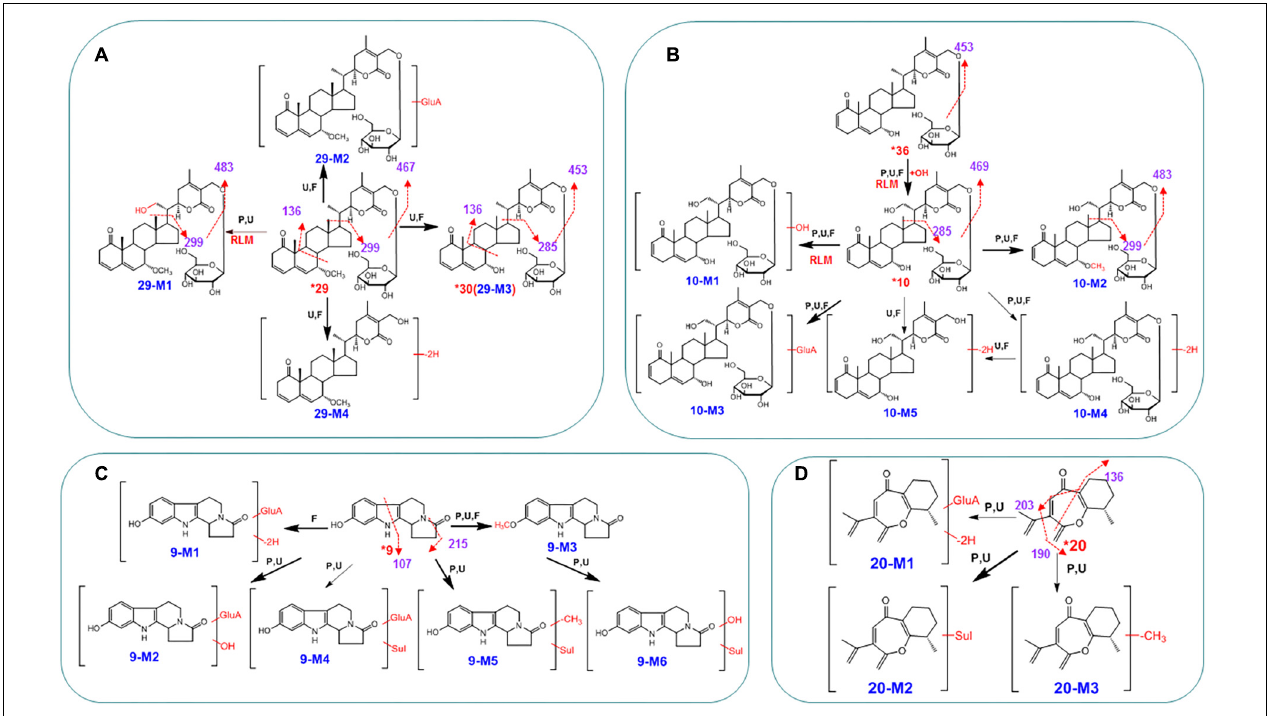
FIGURE 4 | The proposed metabolic pathways for compounds 9 (C) , 10 (B) , 20 (D) , and 29 (A) in rats after the oral administration of the WDS. Red bold arrows indicate major metabolites; ∗ , compared with reference standards; U, detected in urine samples; P, detected in plasma samples; F, detected in fecal samples; RLM, detected in rat liver microsomes; Sul, sulfate; GluA, glucuronic acid